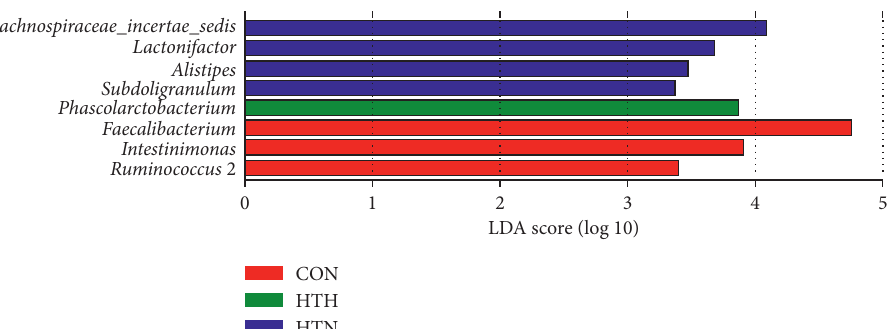
Figure 3: The abundant microbial taxa of fecal community from the three groups. Linear discriminant analysis (LDA) coupled with effect size measurements identified enriched bacterial taxa at the genus level in HTN (blue histograms), HTH (green histogram), and CON (red histograms) group.